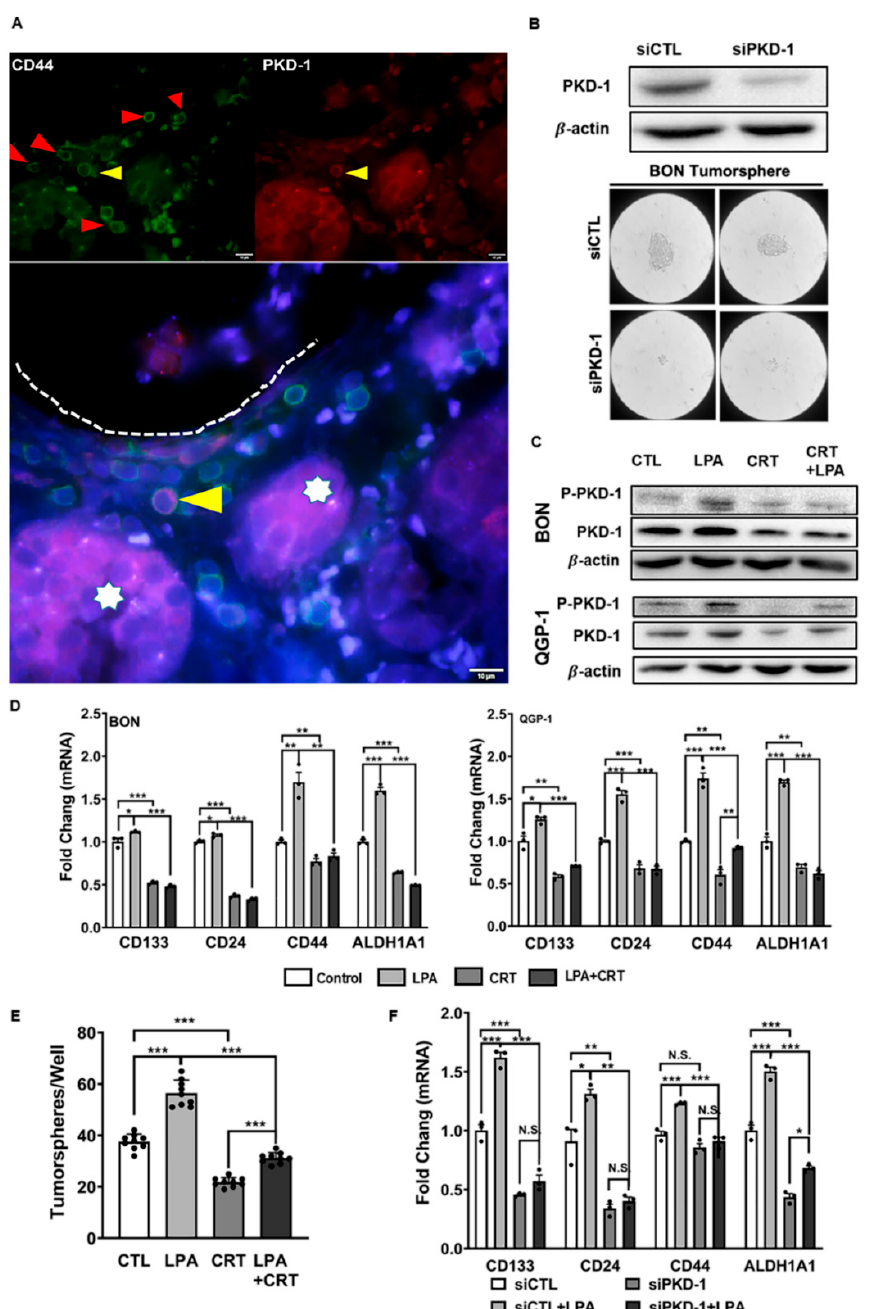
Figure 2. PKD1 signaling in the maintenance of cancer stem-like features in pNETs. ( A ) Distribution of PKD1 + and CD44 + CSCs within the vascular niche. Human pNET specimens were co-stained with CD44 and PKD1 antibodies, followed by appropriate secondary antibodies, with DAPI staining the nuclei (Blue). Stem-like cells with CD44-positive (green), PKD1-positive (red) or both positive (pink) were observed under a fluorescence microscope. A few CD44-positive cancer stem-like cells tended to accumulate near the vascular lumen (red arrow heads). Cancer cell with moderate expression of both PKD1 and CD44 might be leaving tumor nests (stars) for the vascular lumen. The fluorescence images were acquired by a fluorescence microscope equipped with a CCD camera. Shown are representative images. Scale bar = 10 µ m. ( B ) BON cells were transfected with siRNA control and siPKD1 to knock down PKD1. Knockdown efficiency was confirmed by Western Blots (upper panel). The control and BON cells with PKD1 knockdown were subjected to tumorsphere formation assays. Images were acquired by the OLYMPUS CK30 microscope. Representative images are shown for